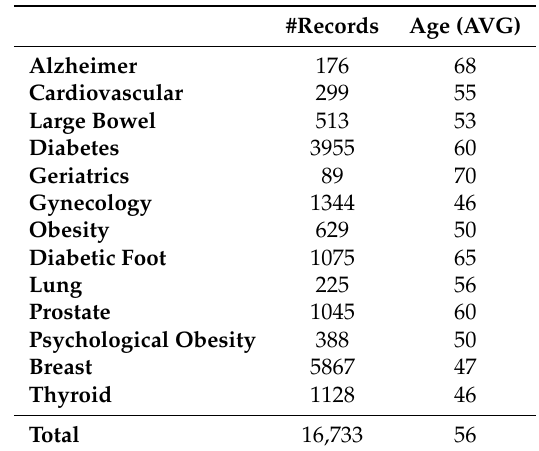
Table 1. Dataset size and stats per each prevention